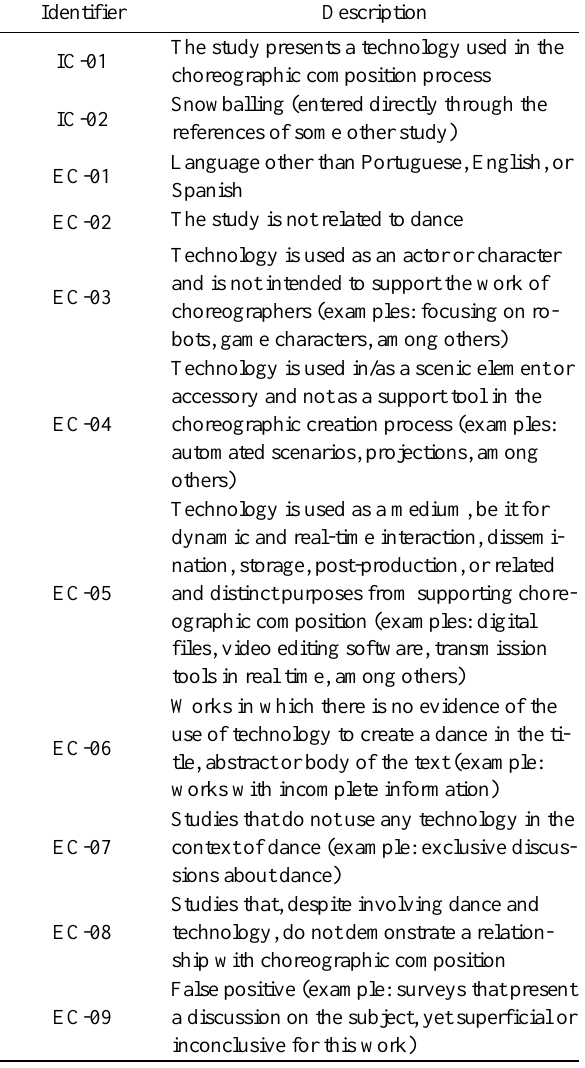
Table 2. Inclusion and exclusion criteria set. Source: The